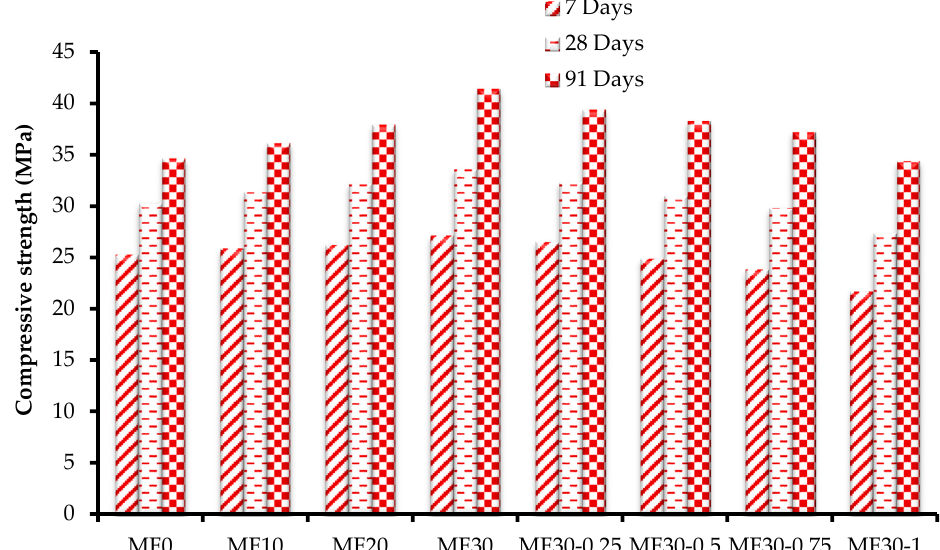
Figure 5. Concrete compressive strength.